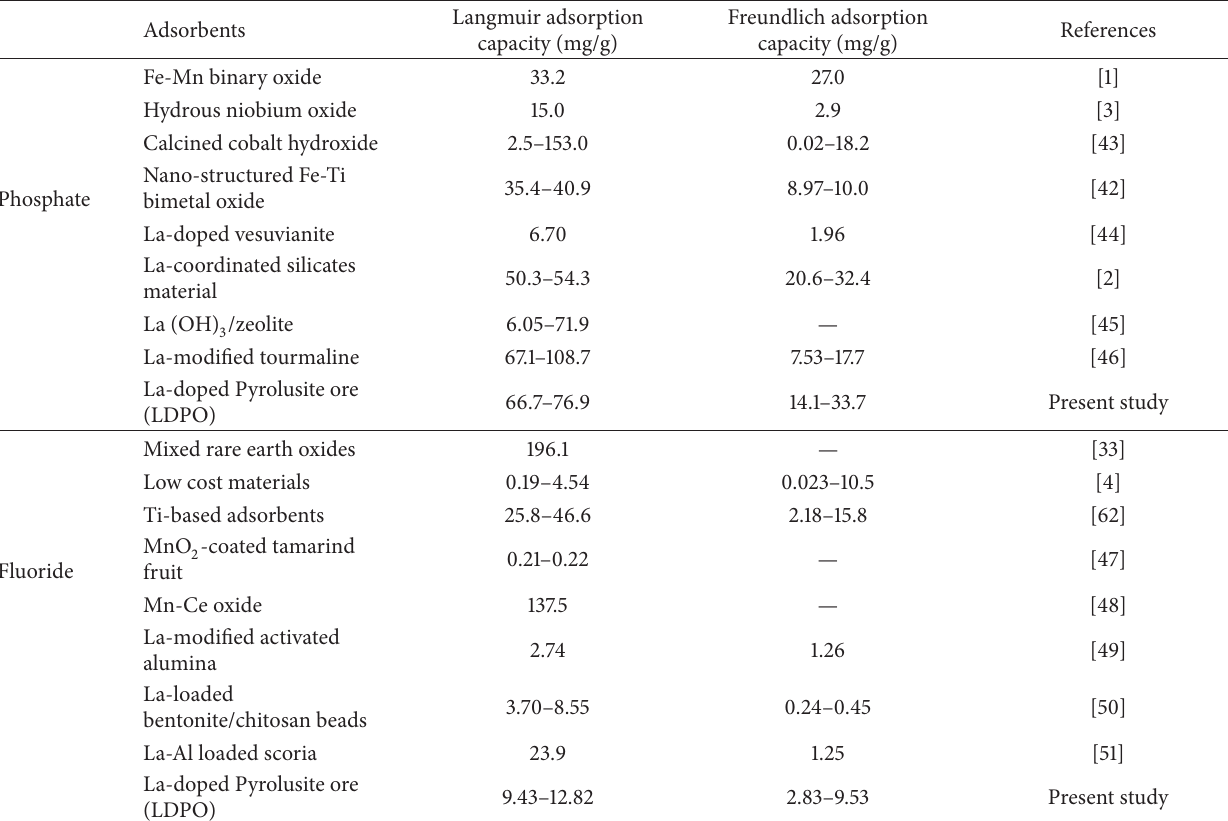
Table 3: Comparison of Langmuir and Freundlich adsorption capacities (mg/g) of various materials for removal of phosphate and